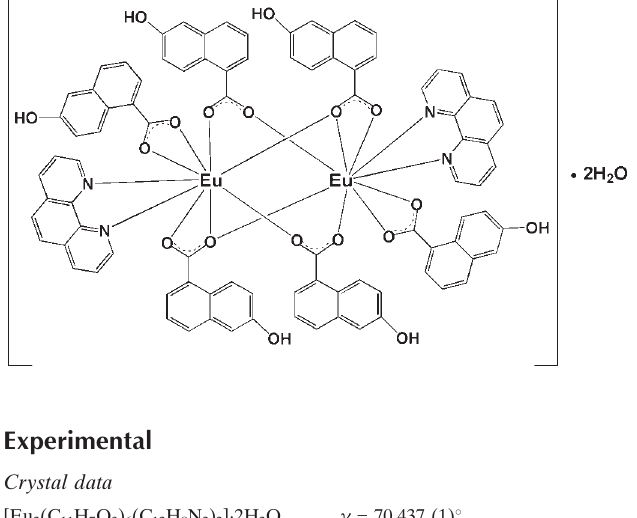
Bruker SMART CCD area-detector diffractometer Absorption correction: multi-scan ( SADABS ; Sheldrick, 1996)